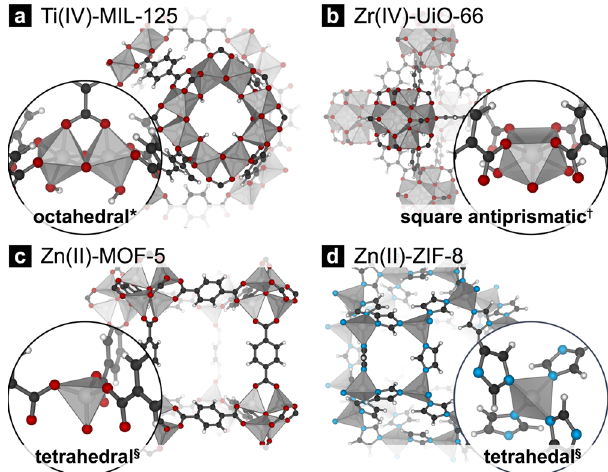
Fig. 3 The relationship between linker pKa and LUMO